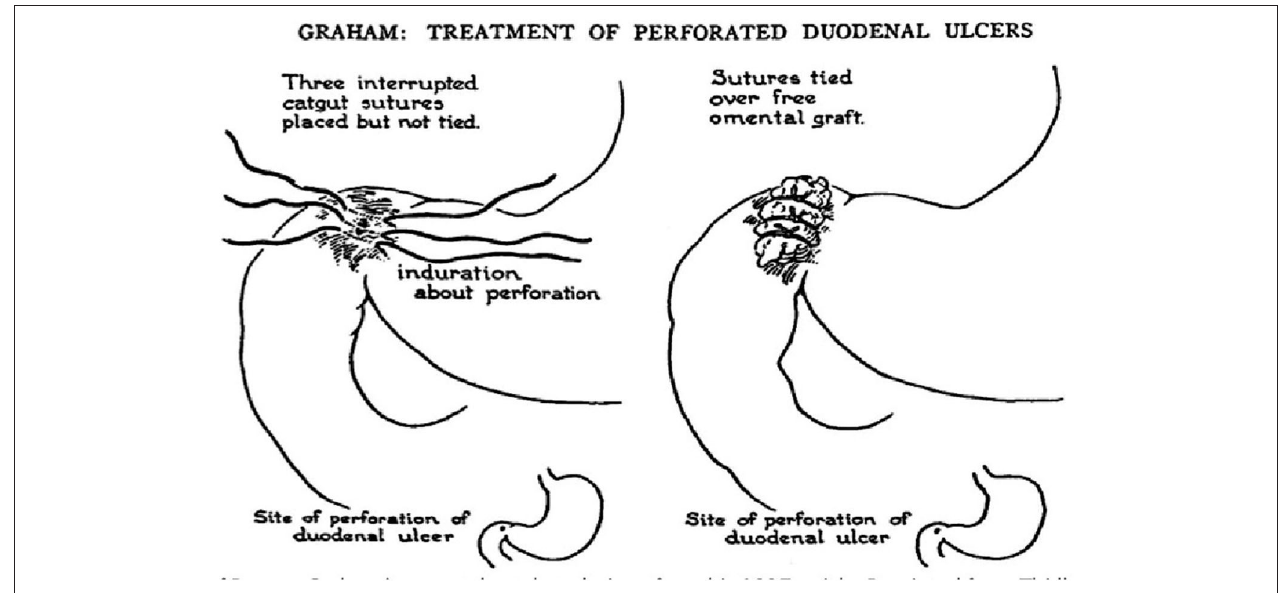
FIGURE 2 | Schematic diagram of omental (Graham) patch technique (plugging with non-pedicle omental flap) [with permission: Graham (29)].